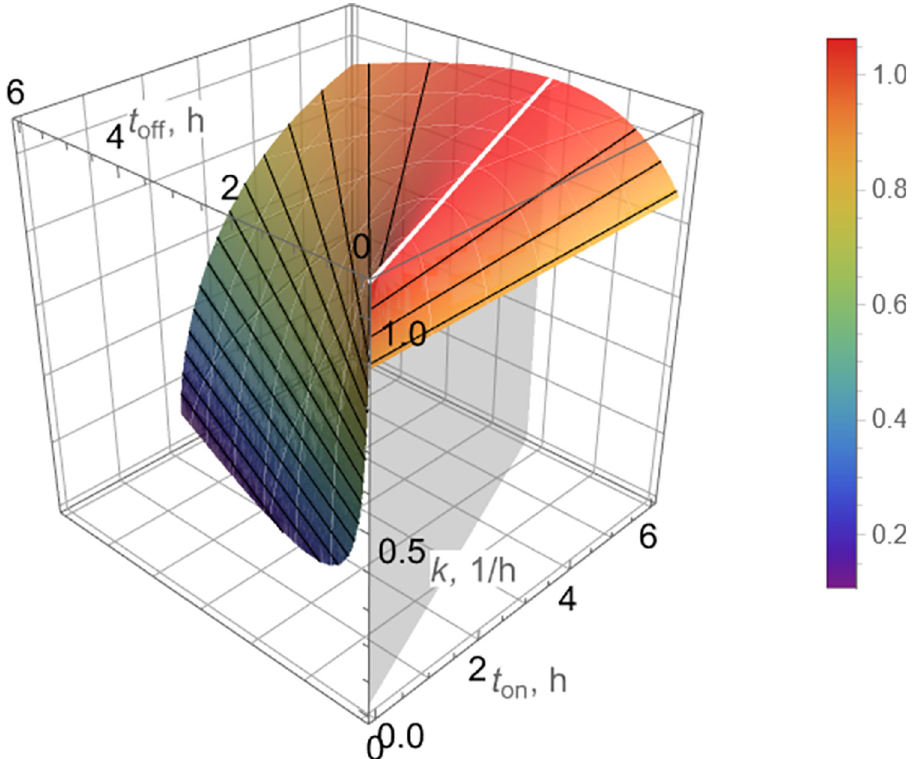
Fig 4. Peak-to-peak decline rate, k , for bacterial count peaks c ( t 2 ) (Eq (9)) as a function of on/off pulse durations, ℓ t on , t off , respectively, for pulse dosing. The decline rate, k , achieves a maximum for ( t off / t on ) opt � 0.4 according to Eq (11) (white line) and remains relatively flat for small variations of t on , t off near ( t off / t on ) opt � 0.4. Note also that isolines (black) are straight, indicating dependence of k on ( t off / t on ) rather than on individual values of t on , t off . https://doi.org/10.1371/journal.pcbi.1010243.g004 Using the above two estimates for K , K in Eq (12) to calculate R and substituting the n ,off n ,on n resulting value of R into Eq (11) yields n